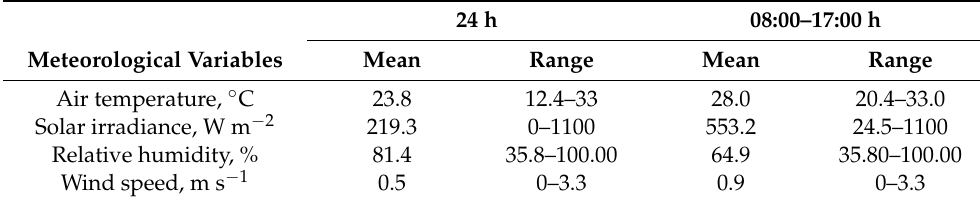
Table 1. Meteorological variables measured during the study period.